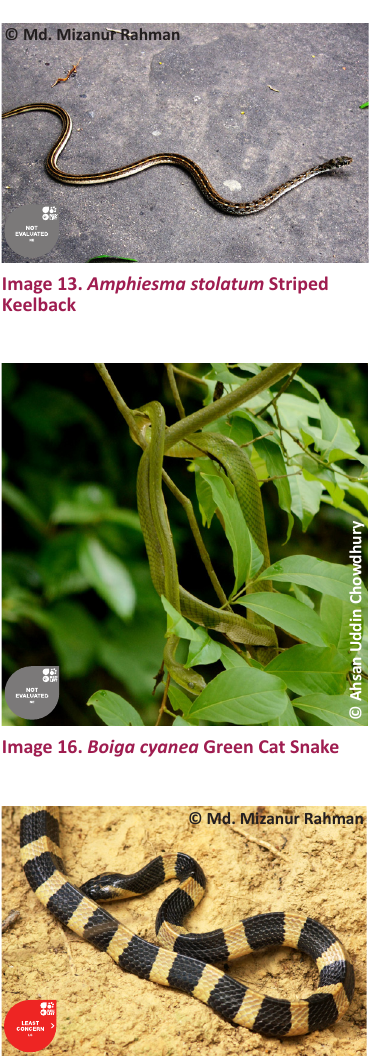
Image 21. Trimeresurus albolabris White- lipped Tree